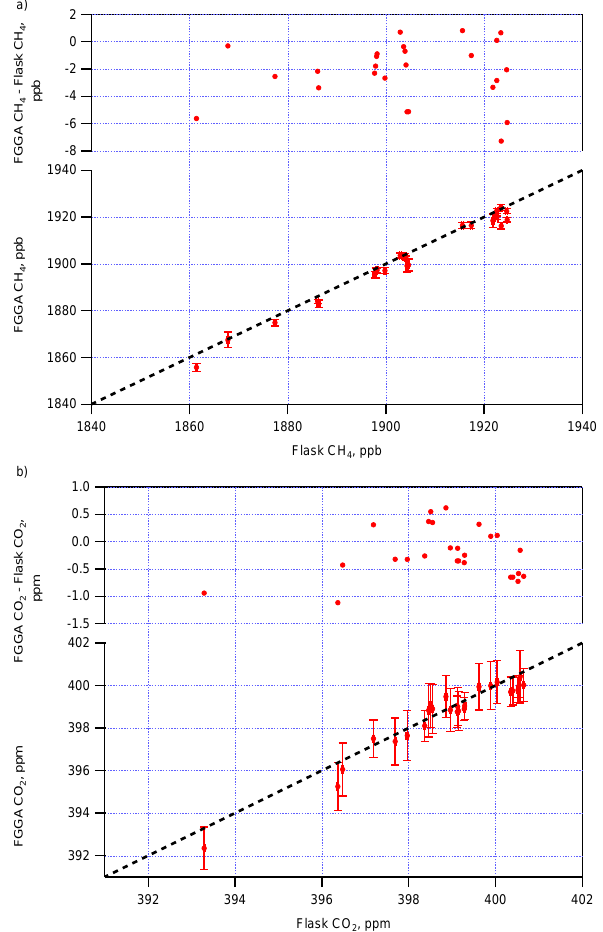
Fig. 7. Scatter plots of FGGA versus whole-air sample measure- ments of (a) CH 4 and (b) CO 2 . Whole-air samples were collected in flasks and analysed post flight using CRDS (Model G2301, Picarro Inc, USA). The FGGA’s original 1Hz measurements were averaged over the filling period of each flask. Error bars are the standard de- viation of the FGGA measurements during each filling period, indi- cating the uncertainty in the averaging of the in situ measurements. The dotted line is the one-to-one